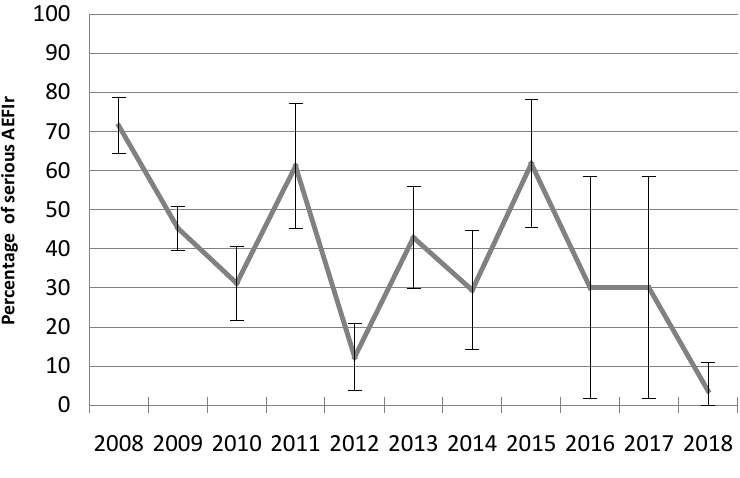
Figure 3. Trend of the percentage of serious AEFI reports in relation with the total AEFI reports in the Valencian Community, Spain (2008–2018).